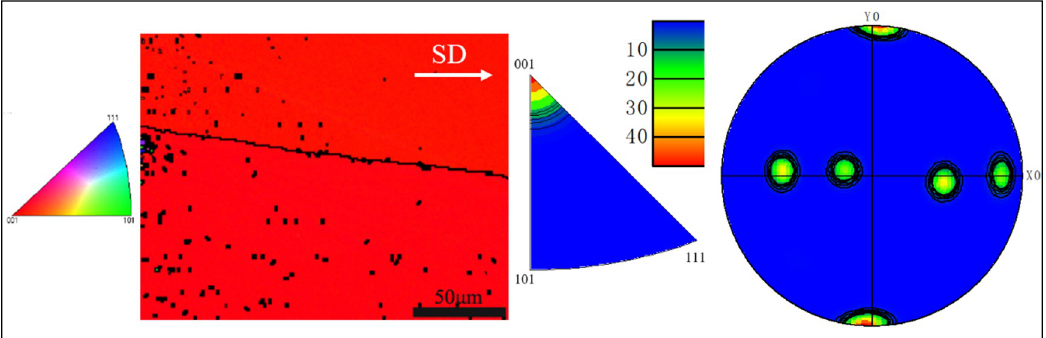
Figure 4. Morphology, inverse pole figure and <001> pole figure of columnar-grained Morphology, inverse pole figure and <001> pole figure of columnar-grained Cu 71.7 Al 18.1 Mn 10.2 alloy sample. SD: Solidification direction. Cu 71.7 Al 18.1 Mn 10.2 alloy sample. SD: Solidification